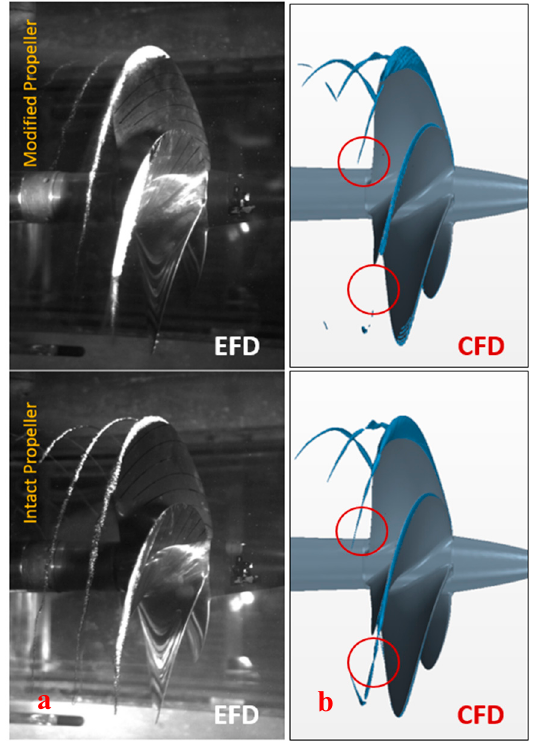
Figure 24. Comparison between ( a ) EFD (Left) and ( b ) CFD (Right) results for intact and modified Propellers.